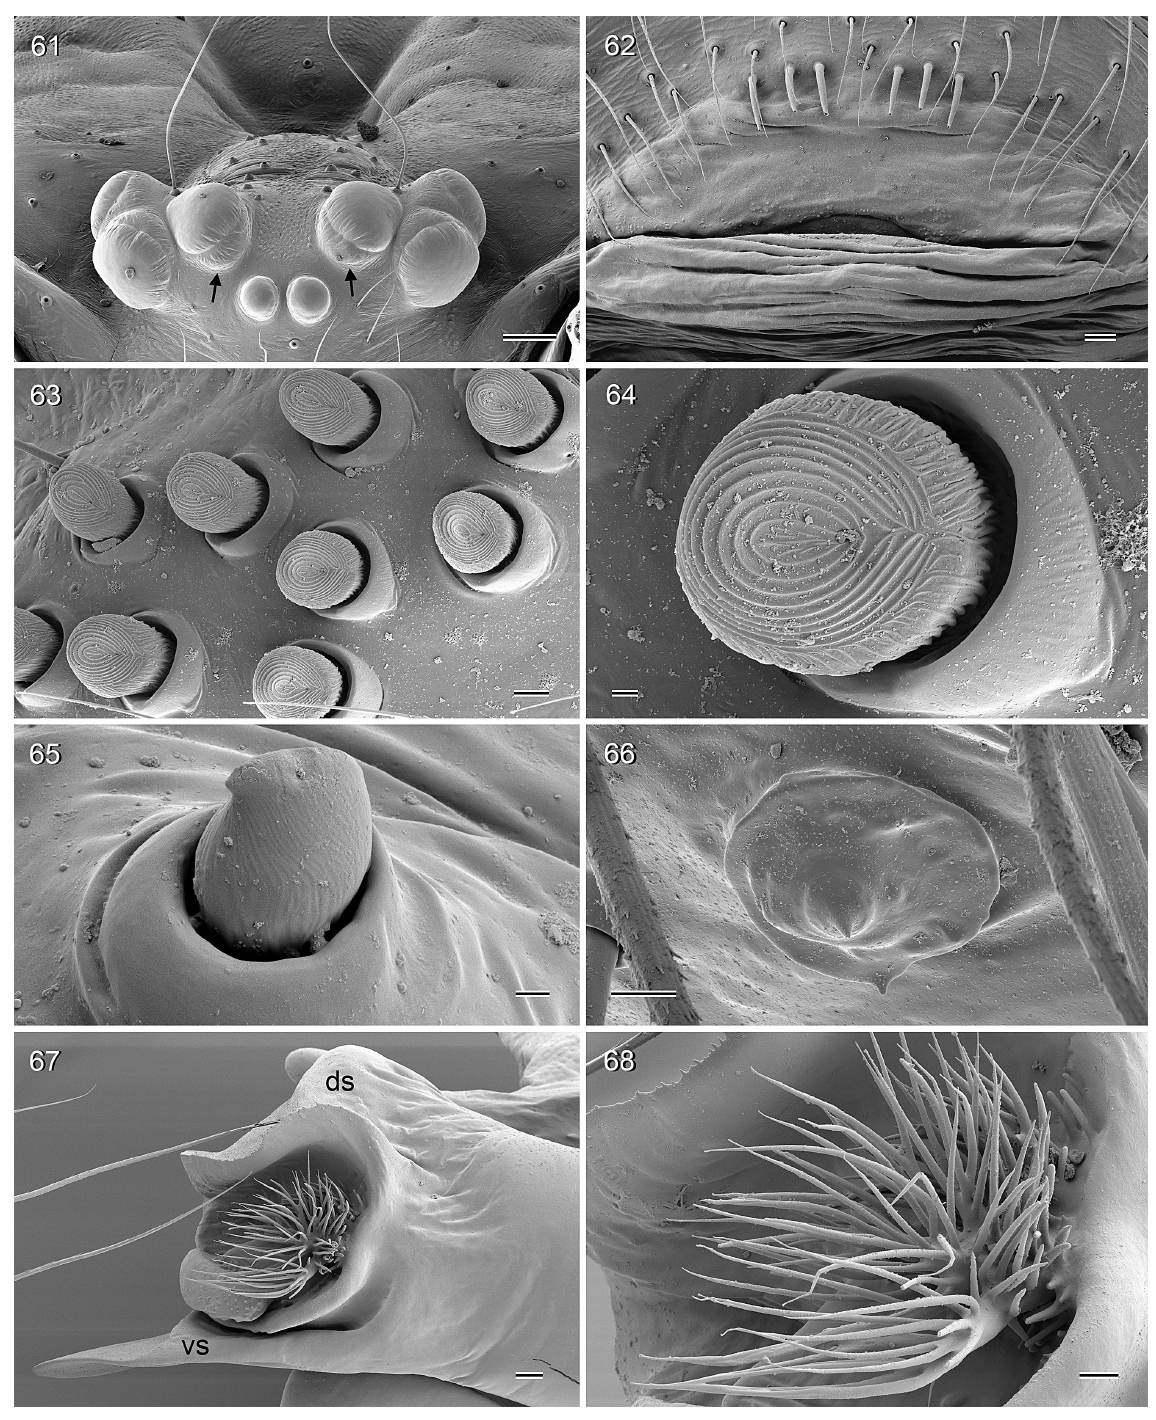
Figs 61–68. Stygopholcus skotophilus Kratochvíl, 1940; male and female from Ilijina pećina, Bosnia and Herzegovina (ZFMK (Ar 22198)). 61 . Male ocular area, frontal view; arrows point at ‘pseudo- eyes’. 62 . Male gonopore and epiandrous spigots. 63–64 . Modified hairs frontally on male chelicerae. 65 . Stridulatory pick on male palpal femur. 66 . Male palpal tarsal organ. 67 . Tip of left procursus, retrolateral view. 68 . Hair-like structures on tip of procursus (detail of previous image). Abbreviations: ds = dorsal sclerite; vs = ventral sclerite. Scale bars: 61 = 100 µm; 62, 67 = 20 µm; 63, 66, 68 = 10 µm; 64–65 = 2